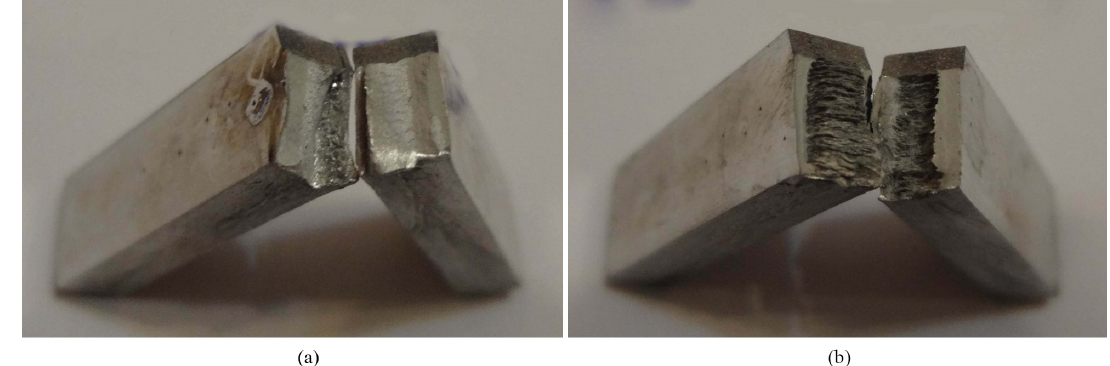
O -free; (b) Al 2 3